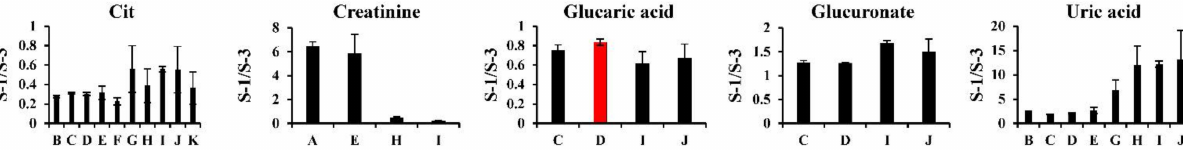
Figure 4. Examples of hydrophilic metabolites with remarkable differences between LC/MS, CE/MS, IC/MS, and GC/MS. As the examples of hydrophilic metabolites with remarkable differences among multiple methods (LC/MS, CE-MS, IC/MS, and GC/MS), the results of relative quantification (S-1/S-3) from the first step data treatment for citric acid (Cit), creatinine, glucaric acid, glucuronate, and uric acid are shown. The values are presented as the mean ± SD obtained from triplicate experiments. Red bars indicate outliers based on one-way ANOVA ( α =